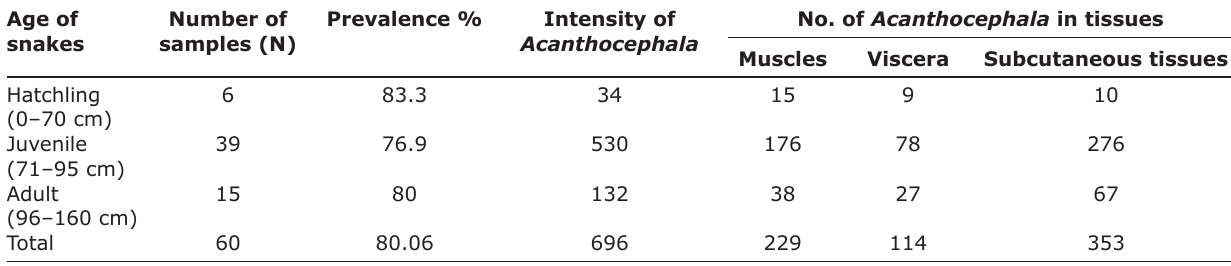
Table-1: Prevalence, intensity, and distribution of Acanthocephalan infection in Asian vine snakes ( Ahaetulla prasina ) from Mojokerto District, East Java Province, Indonesia.